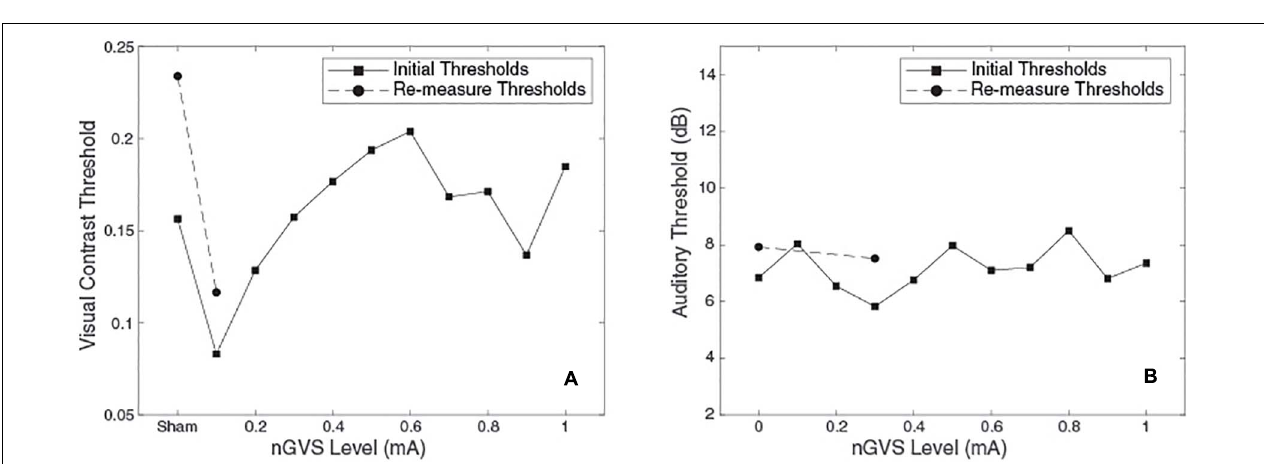
FIGURE 2 | Visual threshold task example presentations. (A) Patch containing only visual static noise (i.e., no signal). (B) Patch containing 40 vertical gratings (i.e., signal). Insets each show close ups of visual stimuli to make it more apparent that panel (B) contains vertical gratings. Subjects were tasked with determining which interval presentation (first or second) contained the vertical